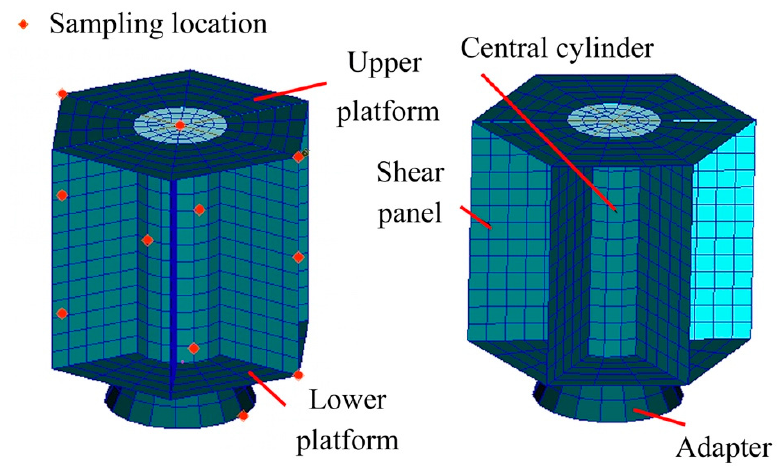
Figure 6. Finite element model of satellite and sampling location.